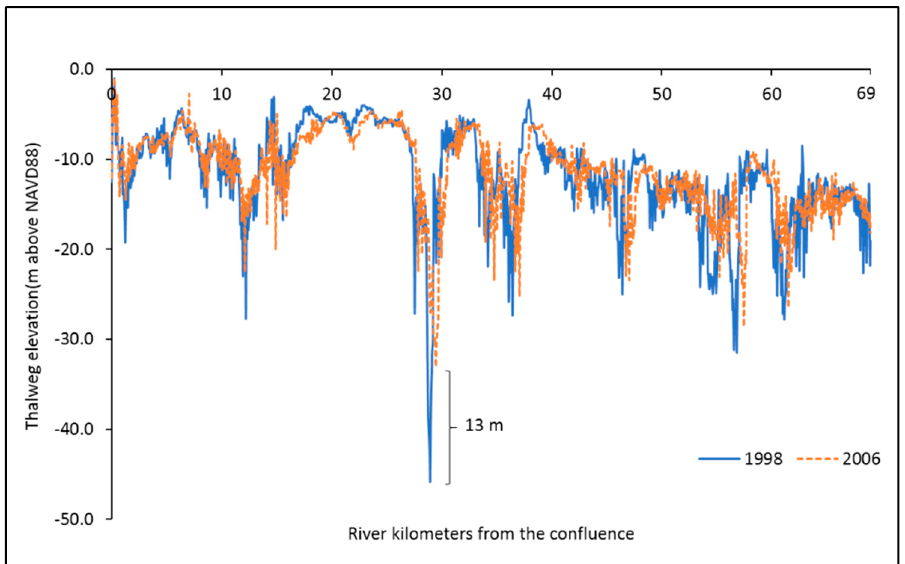
Figure 4. Changes in thalweg profiles from 1998 (blue solid line) to 2006 (orange dash line) in the uppermost 69-km Atchafalaya River. The x -axis is the river kilometers from the confluence between the Red River and the Outflow Channel of the Mississippi-Atchafalaya River diversion.